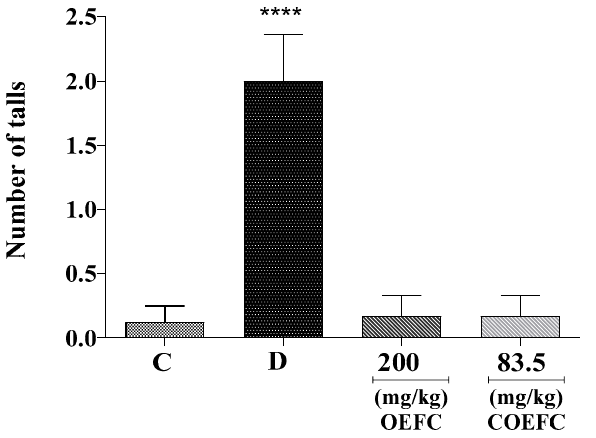
Figure 2. Effect of the OEFC (200 mg/kg/v.o) and COEFC (83.5 mg/kg/v.o.) on the number of falls on the Rota-rod test. Groups: control-C (0.1 mL/10 g/v.o.), diazepam-D (5 mg/kg/v.o.), OEFC (200 mg/kg/v.o.), and COEFC (83.5 mg/kg/v.o.). Values represent the mean ± S.E.M. (standard error of the mean) for groups of 6 animals, where **** p < 0.0001 when compared to the control group. Statistical analysis: ANOVA followed by Dunnett’s test with multiple comparisons.